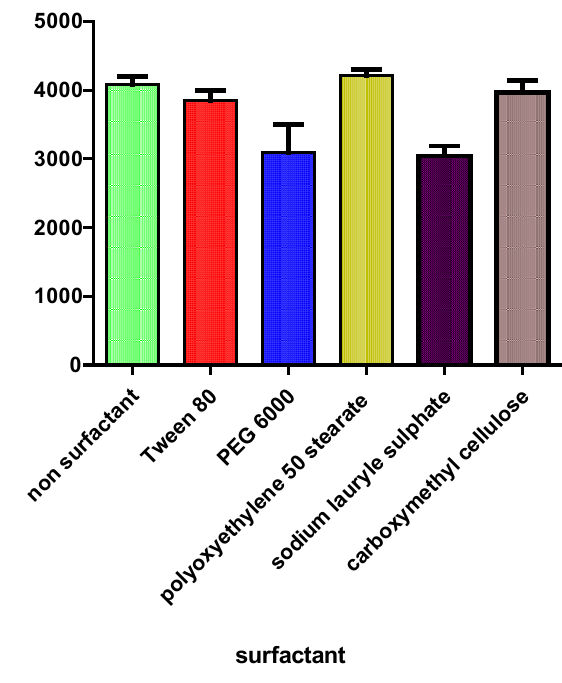
Figure 4: Effect of various surfactant on fluorescence intensity of DCV (60